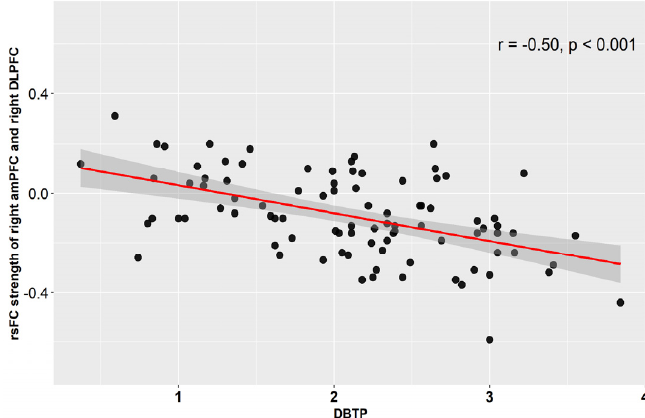
Figure 3. Resting state functional connectivity strength of nodes in DMN (i.e., right amPFC) and FPN (i.e., right DLPFC) showing significant negative correlation with DBTP. DMN = default mode network, FPN = frontoparietal control network, rsFC = resting state functional connectivity (Z- score), amPFC = anterior medial prefrontal cortex, DLPFC = dorsal lateral prefrontal cortex. DBTP = Deviation from Balanced Time Perspective.